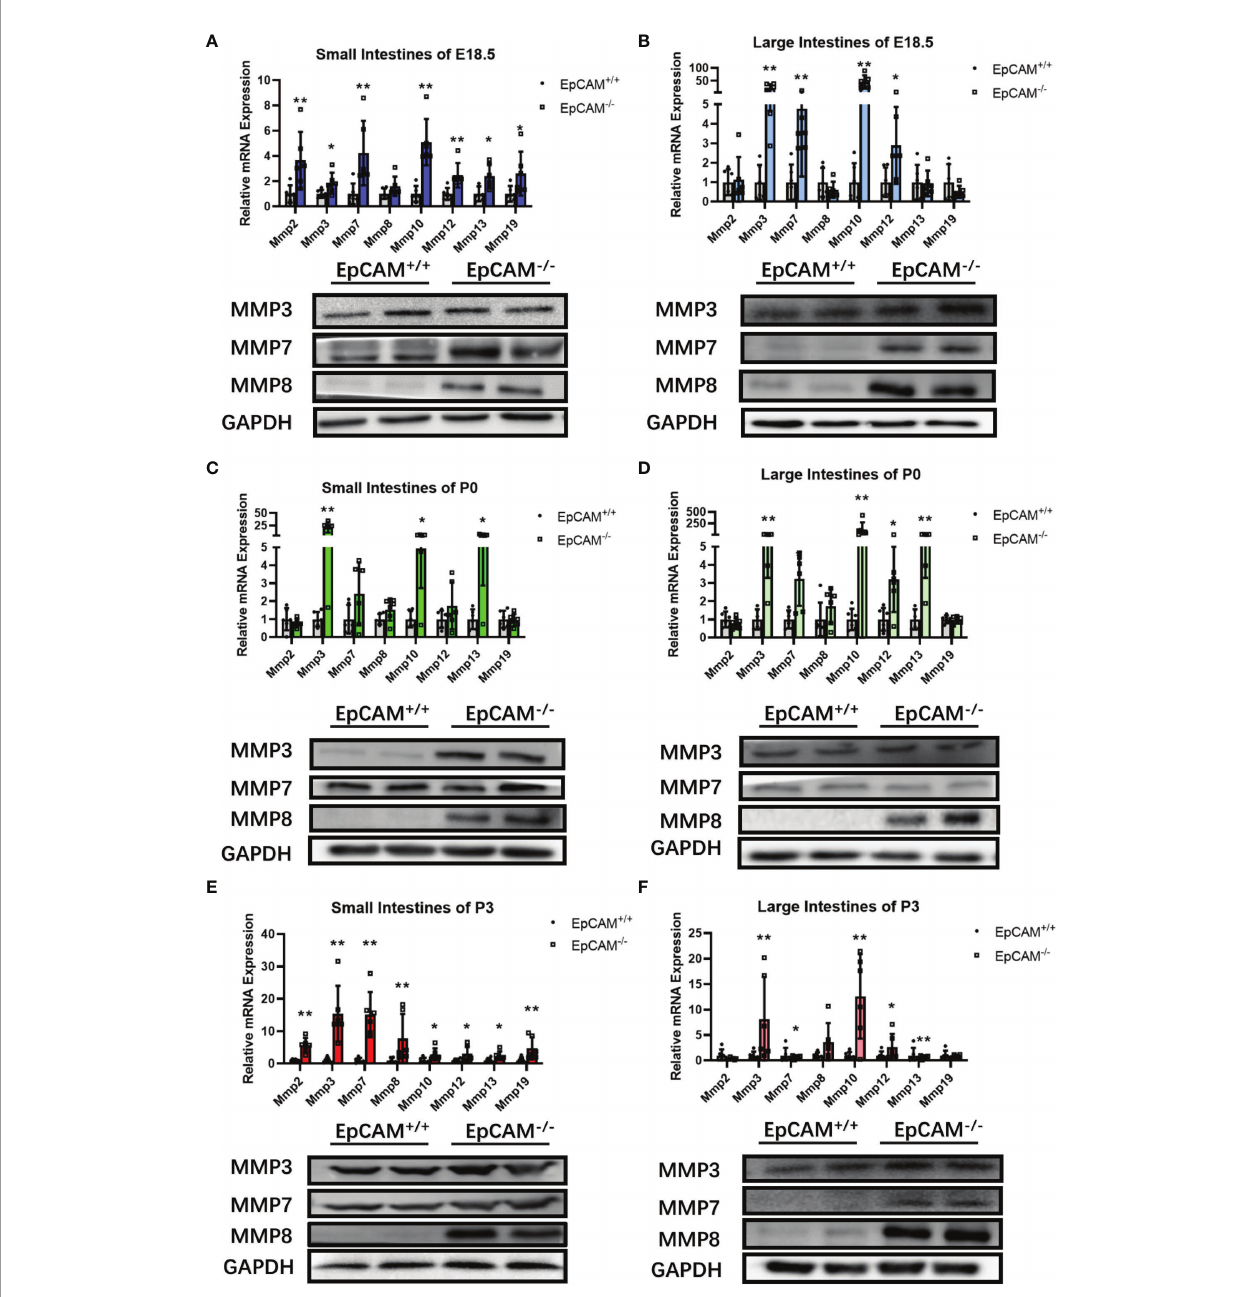
FIGURE 4 | EpCAM de fi ciency induced the overexpression of genes for matrix metalloproteinases in the intestines of mice. (A, B) The relative mRNA expression levels of Mmp2, 3, 8, 10, 12, 13 and 19 (n=6) and the Western blot results of MMP3, 7 and 8 (n=3) in the (A) small and (B) large intestines from WT and EpCAM -/- embryos at E18.5 stage. (C, D) The relative mRNA expression levels of Mmp2, 3, 8, 10, 12, 13 and 19 (n=6) and the Western blot results of MMP3, 7 and 8 (n=3) in the (C) small and (D) large intestines from WT and EpCAM -/- pups at P0 stage. (E, F) The relative mRNA expression levels of Mmp2, 3, 8, 10, 12, 13 (n=6) and 19 and the Western blot results of MMP3, 7 and 8 in the (E) small and (F) large intestines from WT and EpCAM -/- pups at P3 stage (n=3). * p < 0.05, ** p < 0.01, as determined by Mann – Whitney U test. All error bars represent